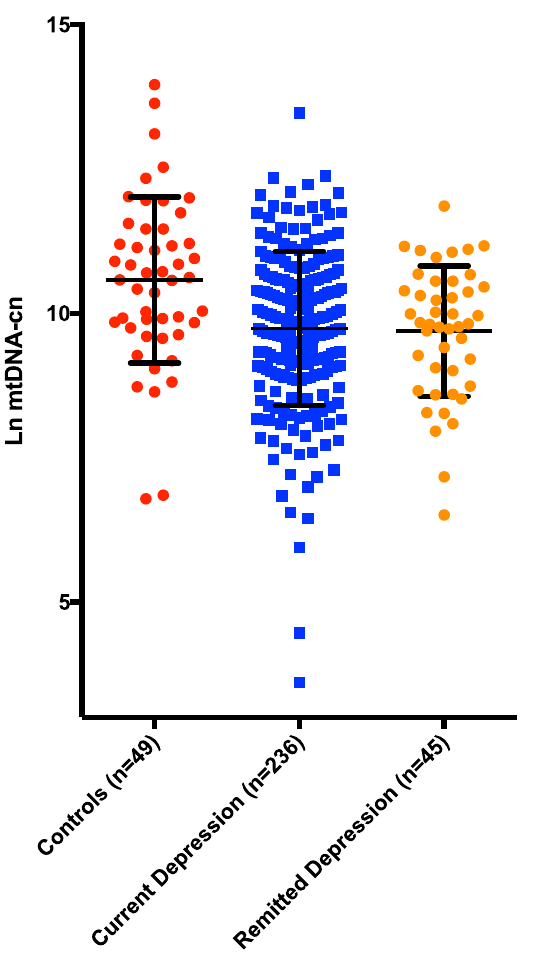
Fig 1. Log transformed ccf-mtDNA in controls, current depression and remitted depression. Error bars represent mean, SD. The group effect was significant (F = 8.3, p < 0.001, adjusted for age and sex). Post-hoc tests revealed that patients with current (p < 0.001) and remitted (p = 0.002) depression had lower ccf-mtDNA compared to